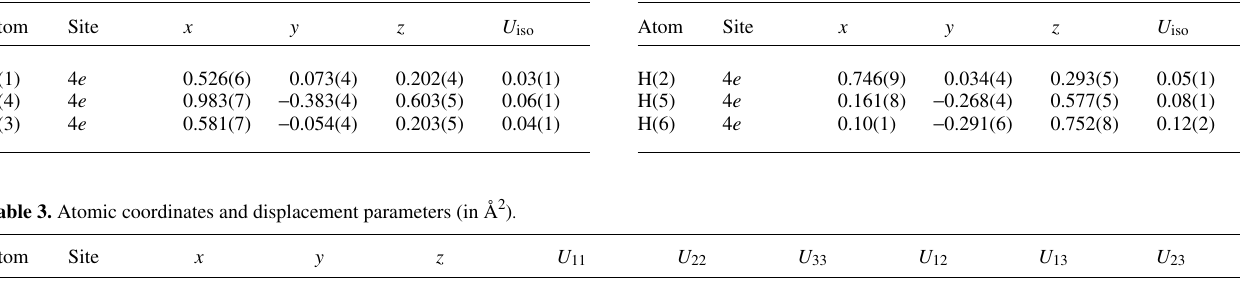
Table 2. Atomic coordinates and displacement parameters (in Å 2 )